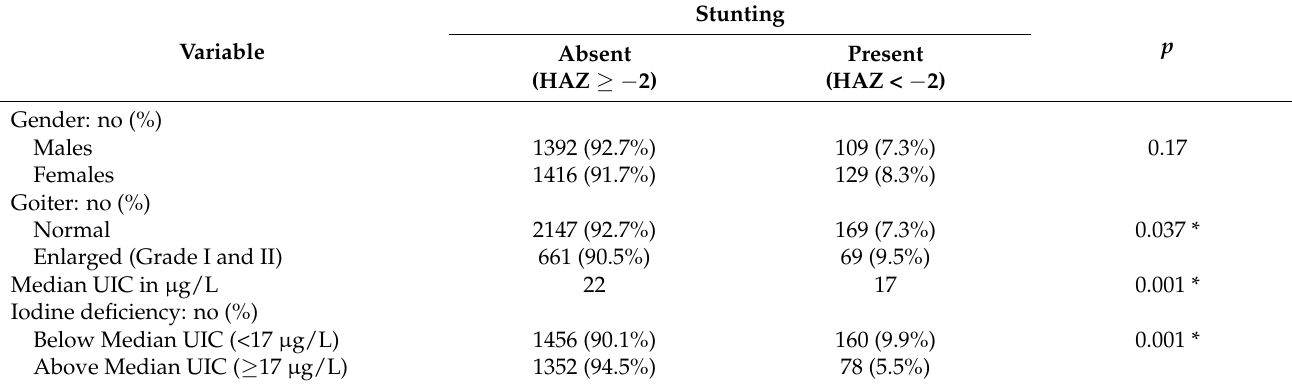
Table 1. Sociodemographic, clinical, and biochemical correlates of stunting among school children ( n = 3046).